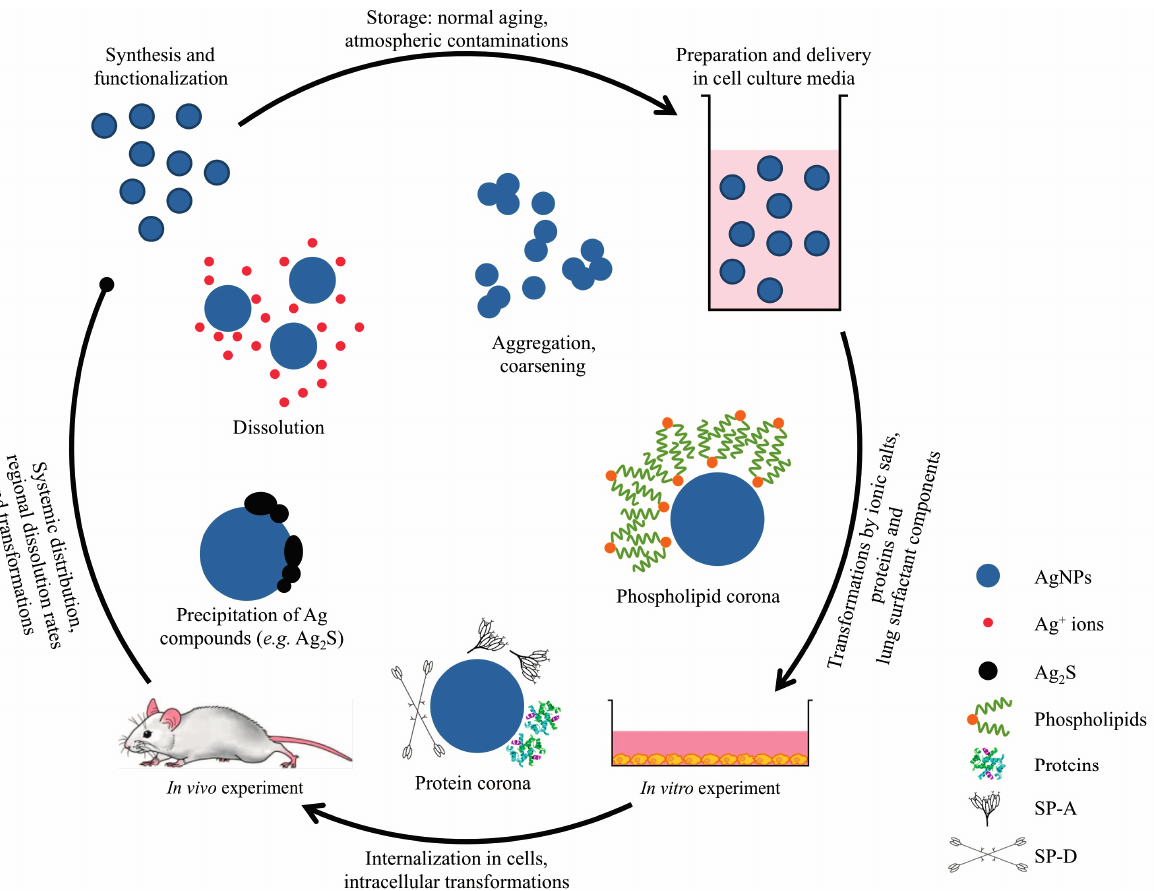
Figure 1. Examples of transformations to the physicochemical properties of silver nanoparticles (AgNPs). To elucidate the mechanisms of biological action of AgNPs, these transformations must be carefully considered and comprehensive characterization should take place at each stage of the in vitro and in vivo